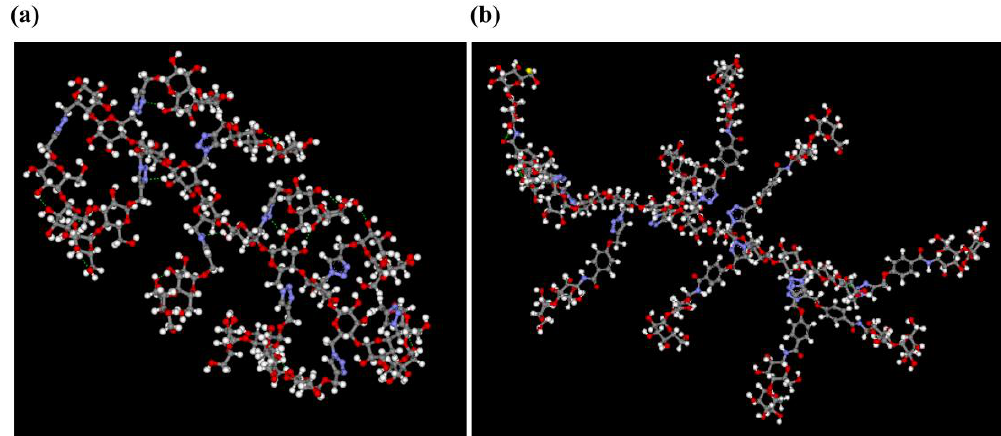
Figure 6. The most stable conformation of ( a ) Cel- O -Mal and ( b ) Cel- N -Mal (10-mer) during the dynamics (1 ns, CHARMm, 300K, NVT,